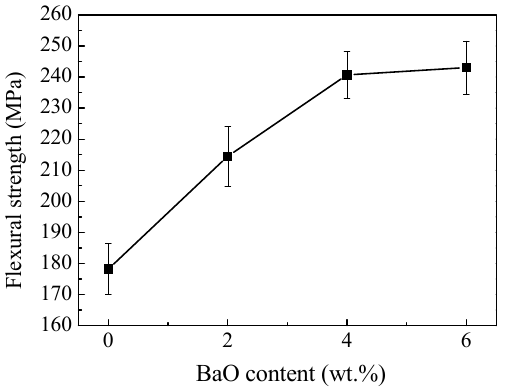
Figure 6. Effect of BaO addition on the flexural strength of the samples after heating at 1600 °C for 2 h in air.